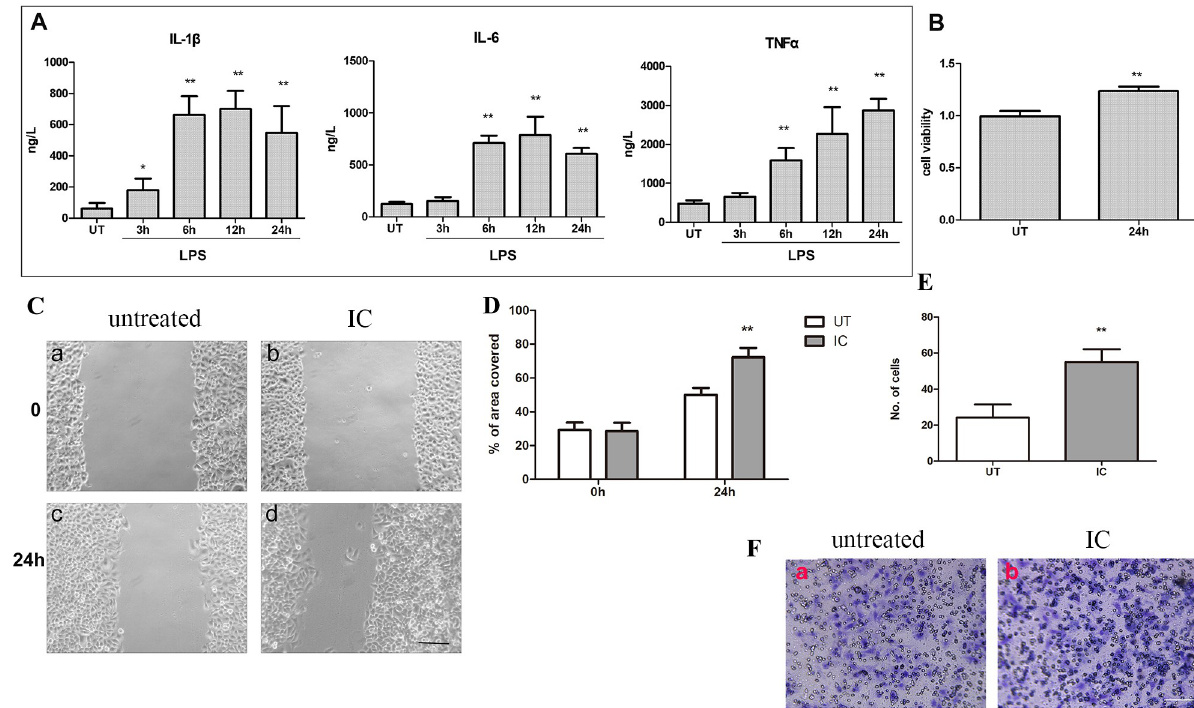
Fig 1. Effect of the inflammatory condition on tumor cell invasion and proliferation. A: Change in the IL-1 β , IL-6, and TNF- α levels in THP-1 cells under LPS stimulation. B: Cell viability under the inflammatory condition after 24 hours using the CCK8 assay. C-D: Cell migration was observed under the inflammatory condition after 24 hours using the wound healing assay. Scale bar = 50 μ m. E-F: Cell invasion was observed using the Transwell chamber set. Scale bar = 20 μ m. Statistical significance is denoted by � P < 0.05, �� P < 0.01, IC group vs UT group. UT: untreated group; IC: inflammatory